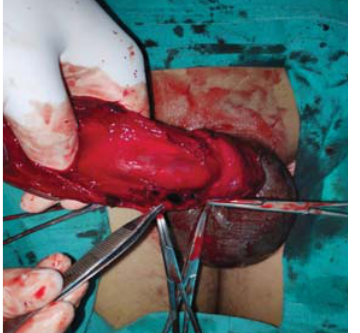
Figure 3. Rent in the tunica albuginea in the ventral shaft